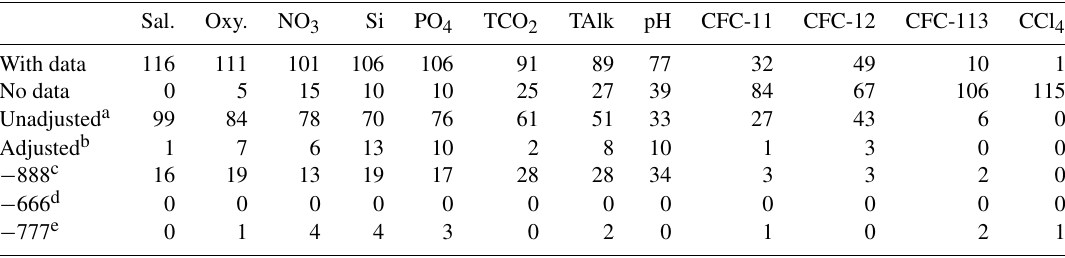
Table 5. Summary of secondary QC actions per variable for the 116 new cruises. Sal. Oxy. NO 3 Si PO 4 TCO 2